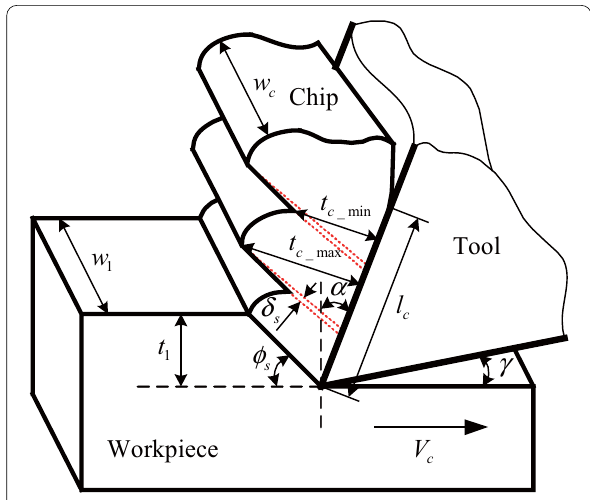
Figure 3 Orthogonal cutting configuration and parameters for a serrated